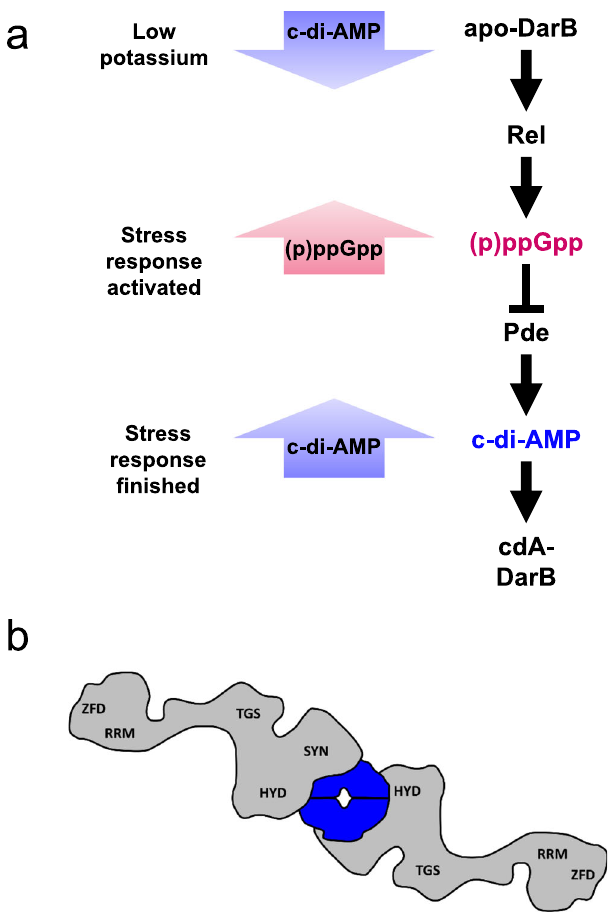
Fig. 5 The link between c-di-AMP and (p)ppGpp signaling in B. subtilis . a The model depicts the bidirectional and dynamic process of the cellular response to potassium limitation. When potassium becomes limiting, the diadenylate cyclases respond and produce less c-di-AMP and c-di-AMP receptor proteins are present in the apo-form. One apo-DarB dimer binds to Rel and by this disrupts the Rel dimer. This leads to formation of the DarB – Rel complex as suggested by the presented data. One DarB dimer is bound by two Rel monomers, one on each side. The interaction occurs via the HYD-SYN domains of Rel. Interaction of DarB with Rel leads to stimulation of (p)ppGpp synthesis. (p)ppGpp accumulation induces the stringent response and inhibits the c-di-AMP-degrading phosphodiesterases GdpP and PgpH. This leads to increasing intracellular c-di-AMP amounts. DarB can then bind c-di-AMP and is thus no longer able to interact with Rel. b The model shows the DarB-Rel complex as suggested by our data. One DarB dimer is bound by two Rel monomers, one on each side. The interaction occurs via the HYD-SYN domains of Rel. DarB, blue; Rel, gray. cdA, c-di-AMP; HYD, hydrolase domain; SYN, synthetase domain; TGS, TGS domain (for: ThrRS, GTPase, and SpoT); ZFD, Zinc fi nger domain; RRM, RNA Recognition